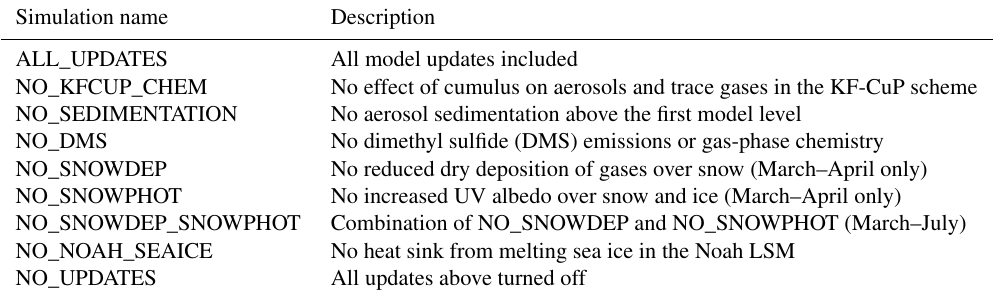
Table 2. Simulation list and